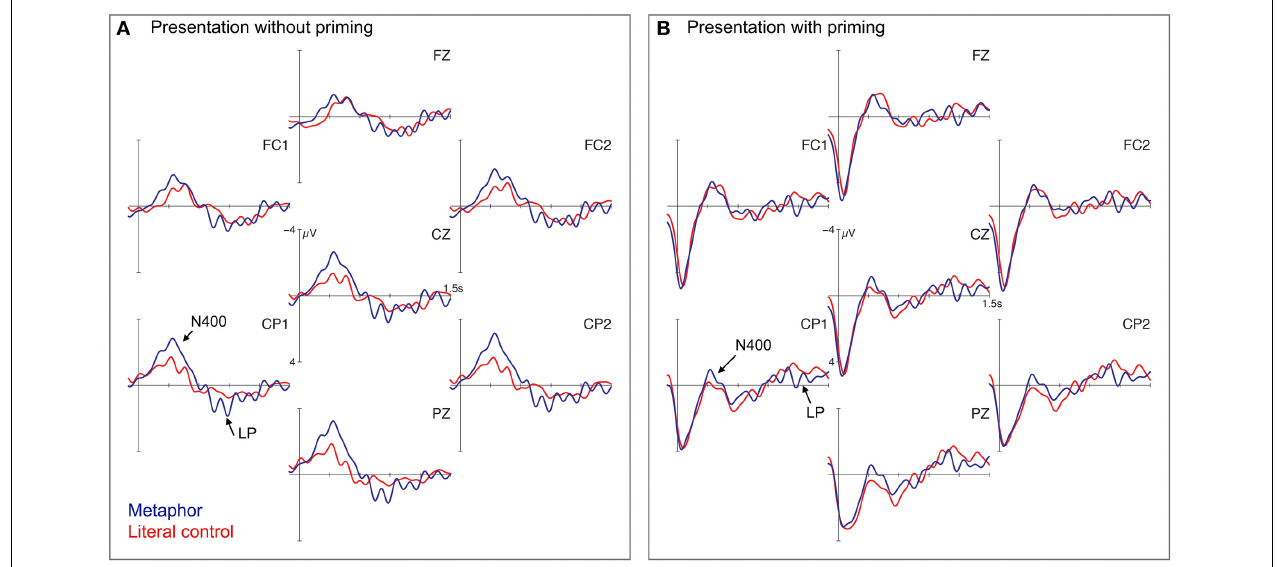
FIGURE 3 | GrandaverageERPsforExperiment1aand1b. GrandaverageERPsfor7selectedelectrodesitesformetaphorical(blue)andliteral(red)conditions withoutprimingin (A) (Experiment1a)andwithprimingin (B)